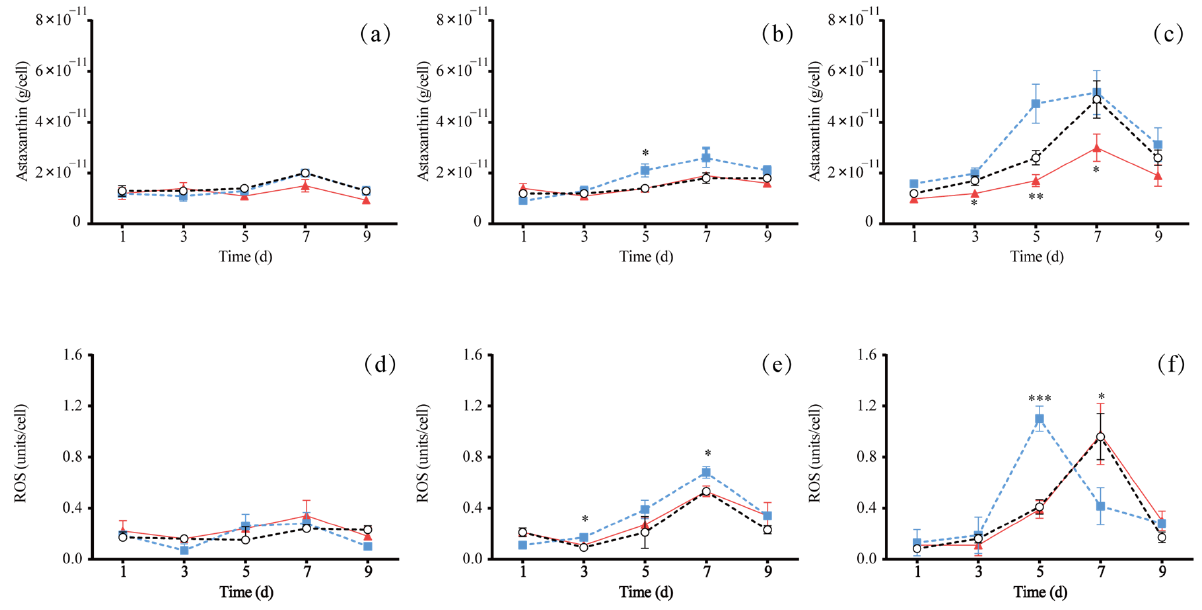
Figure 5. Astaxanthin curves of H. lacustris under light intensities of ( a ) 18 μ mol/m 2 ·s, LL; ( b ) 55 μ mol/m 2 ·s, ML; ( c ) 110 μ mol/m 2 ·s, HL. ROS curves of H. lacustris under light intensities of ( d ) 18 μ mol/m 2 ·s, LL; ( e ) 55 μ mol/m 2 ·s, ML; ( f ) 110 μ mol/m 2 ·s, HL. Treatments are white (open circle), blue (blue box), and red (red triangle) LED lights. Error bars show the standard deviation for three replicates. Asterisks indicate statistically significant differences resulting from Student’s t -tests: * p < 0.05, ** p < 0.01, *** p < 0.001.